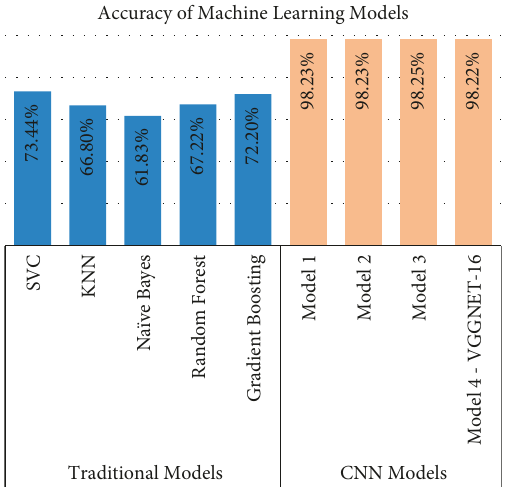
Figure 15: Comparison of different tested models and their overall accuracy. Table 6: Execution time comparison for machine learning algorithms. Algorithm Time taken for training (s) Time taken for classification